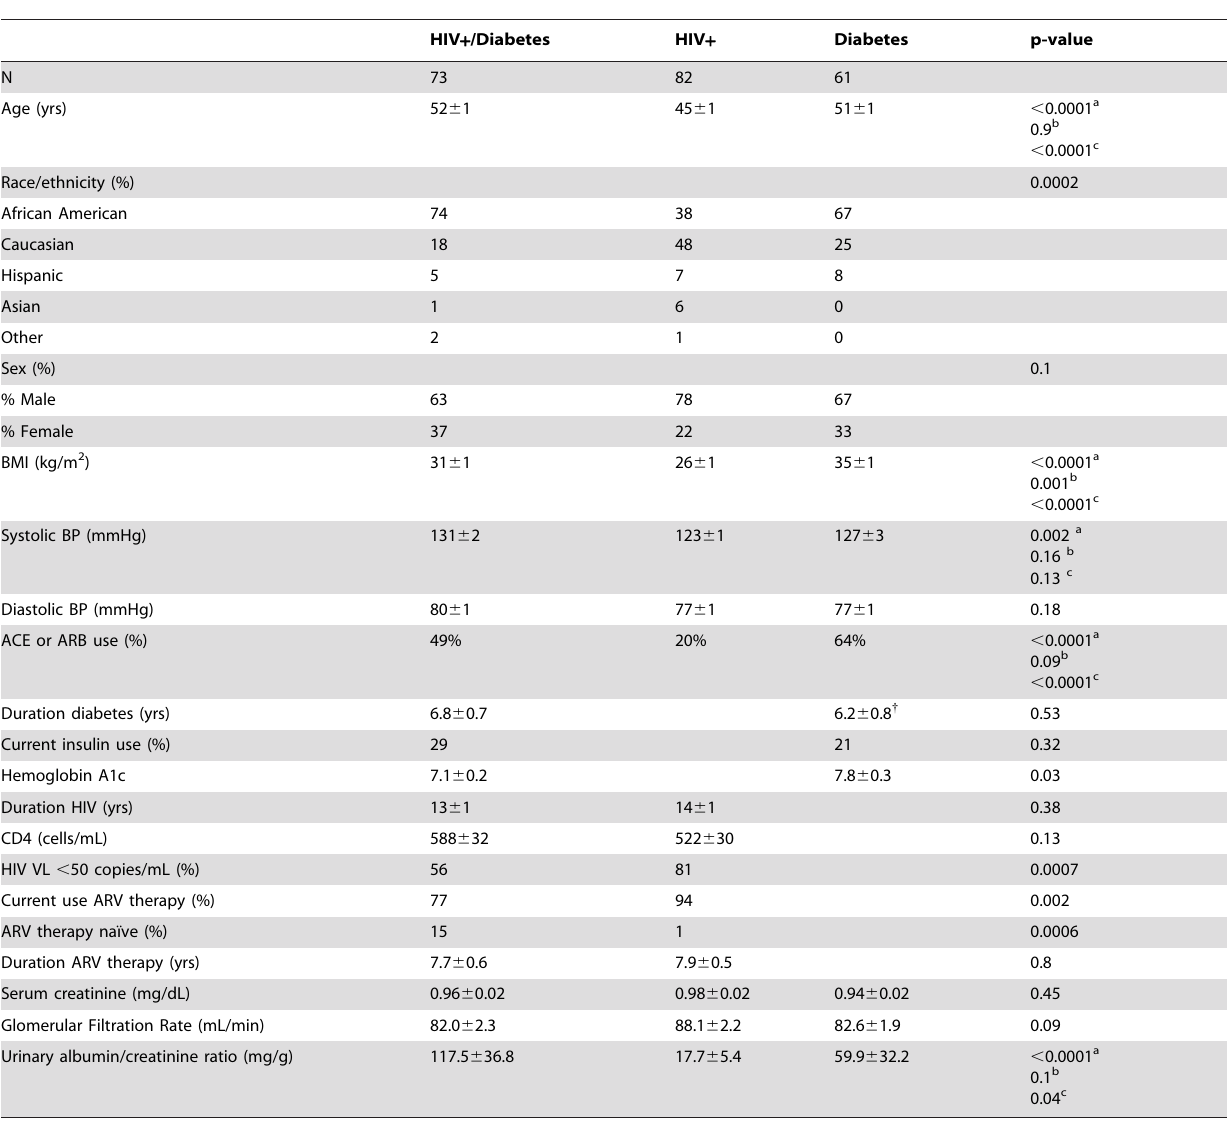
Table 1. Demographic and Clinical Characteristics of Subjects with HIV, Diabetes and both HIV and Diabetes.